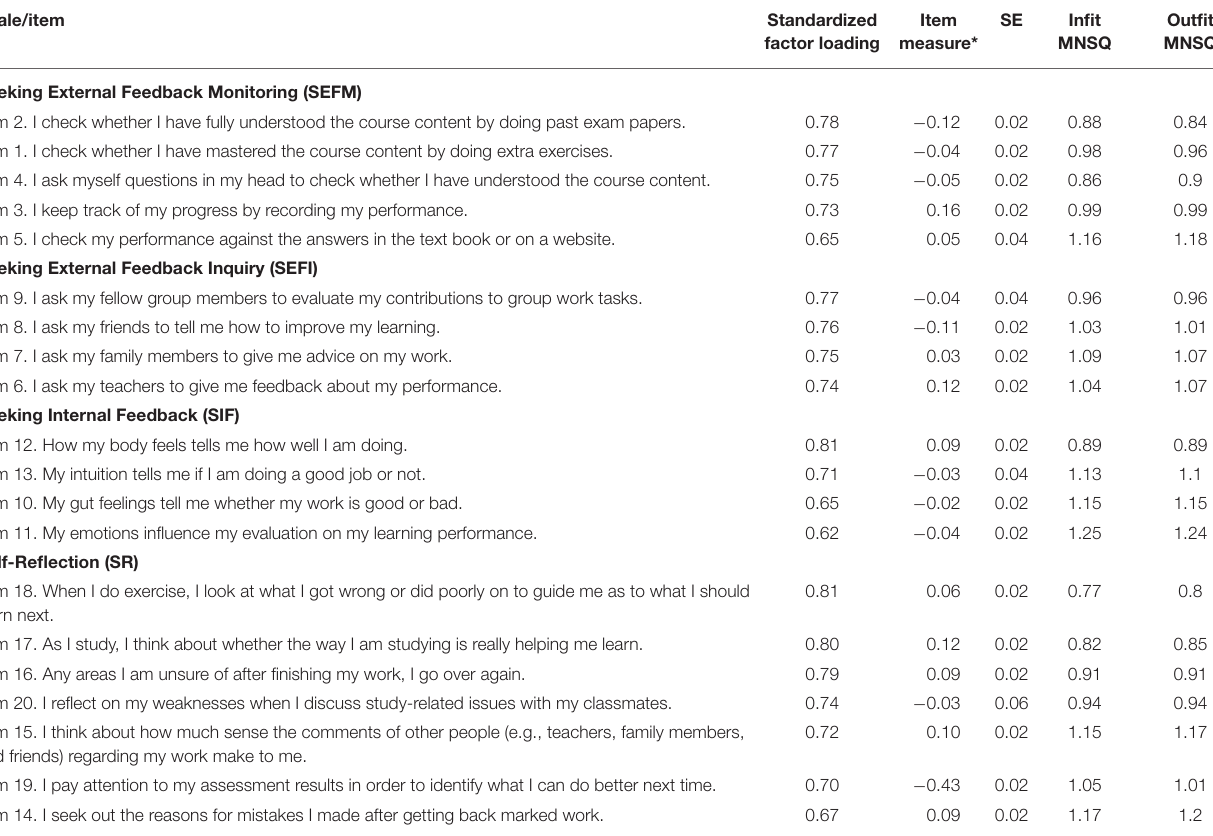
TABLE 1 | Psychometric indicators for the SaPS-20 from CFA and Rasch analysis.